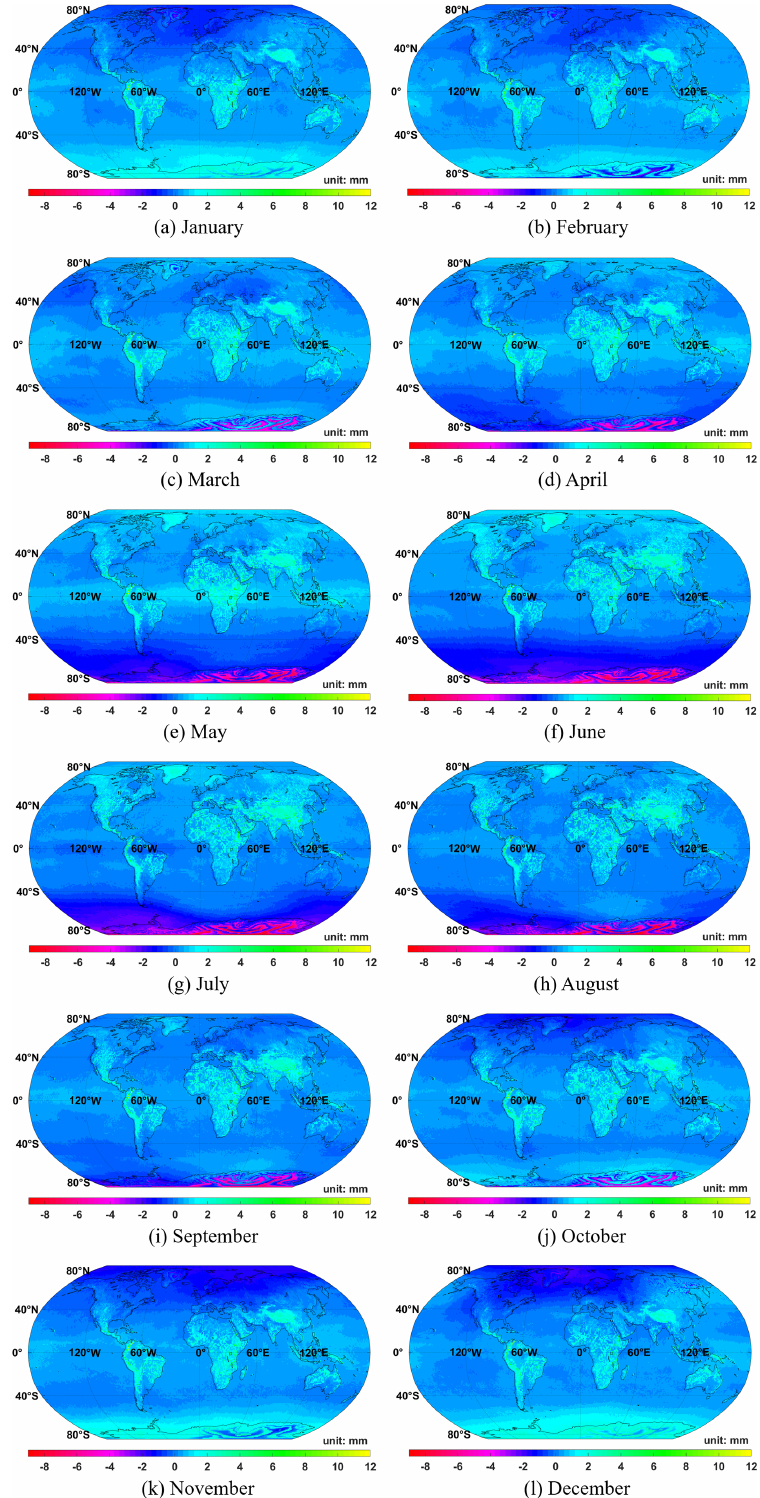
Figure 6. Global distribution maps of monthly averaged ZHD systematic biases between SAAS D ZHD and integral ZHD. Panels (a) – (l) represent the monthly averaged biases from January to December 2020. In order to distinguish the variations between different months, we use the same scale color bars in the 12 panels